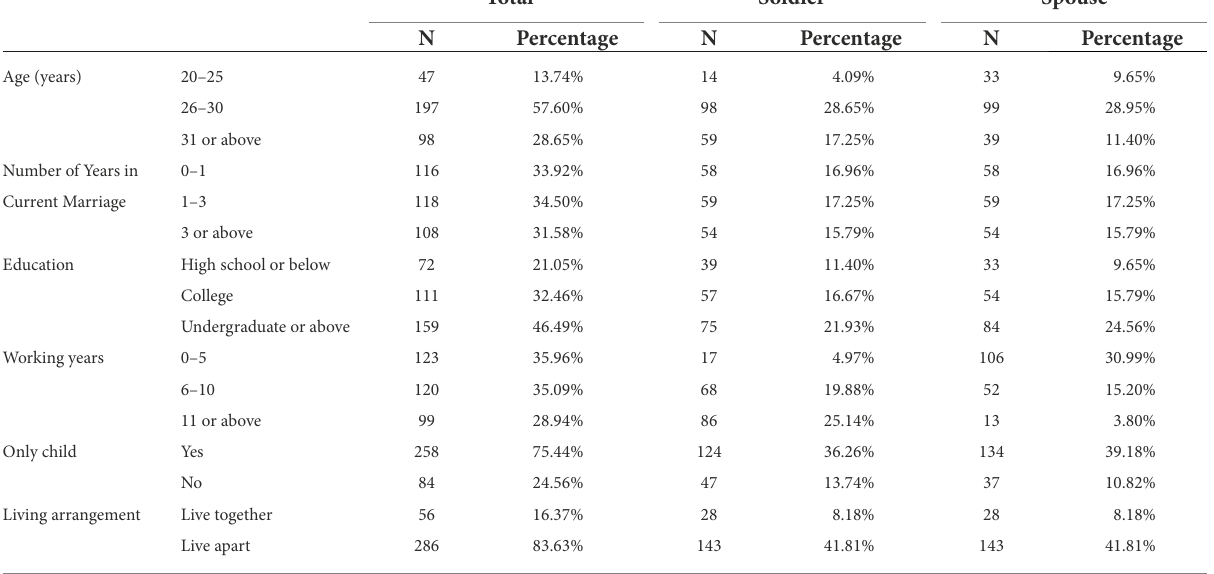
TABLE 1 Demographic information of